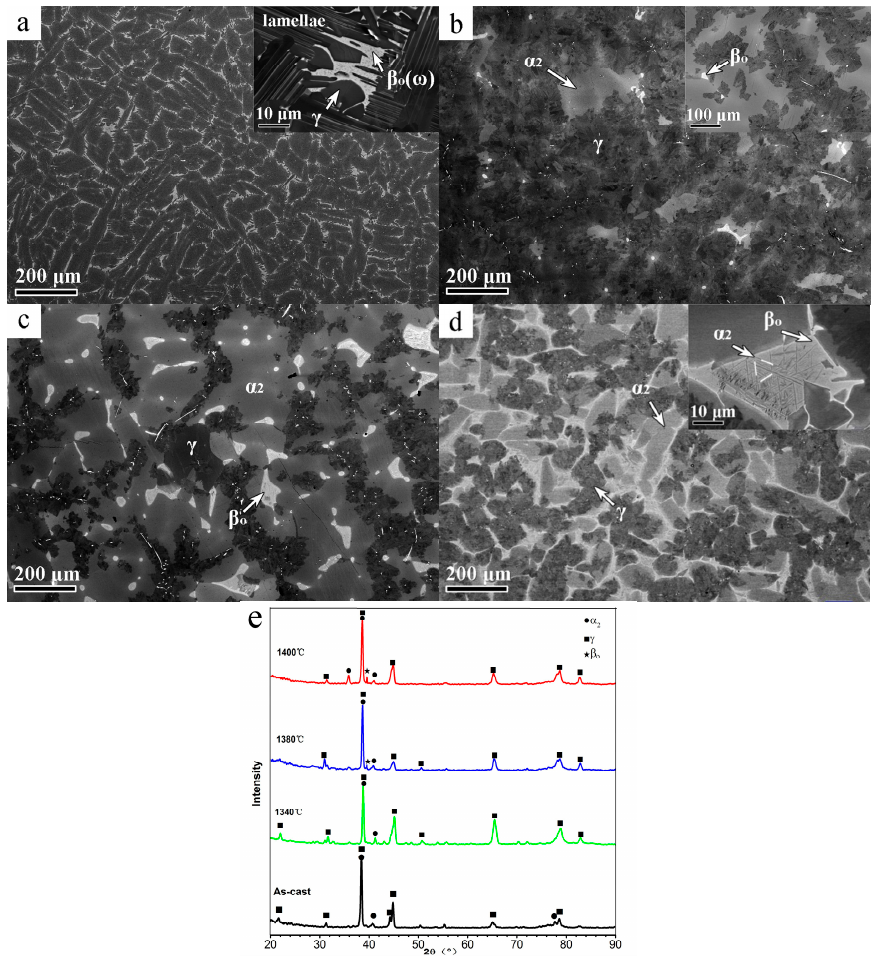
Figure 1. SEM images of the as-cast microstructure ( a ) and microstructures after heat treatment at 1340 °C ( b ), 1360 °C ( c ), and 1400 °C ( d ) for 30 min followed by water-quenching, the corresponding x-ray diffraction patterns of the above microstructures are shown in ( e ).